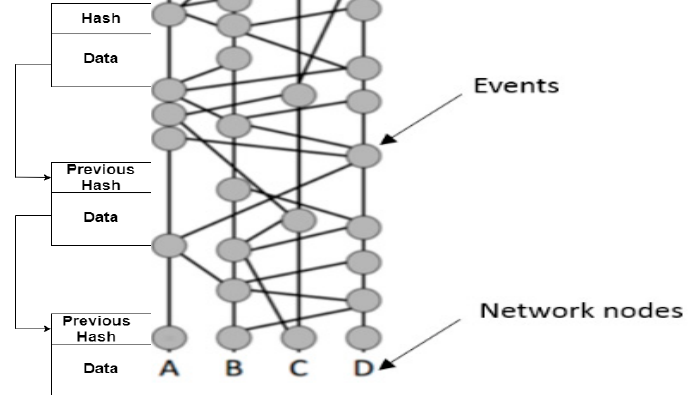
Figure 4. Diagrammatical difference between blockchain and hashgraph.